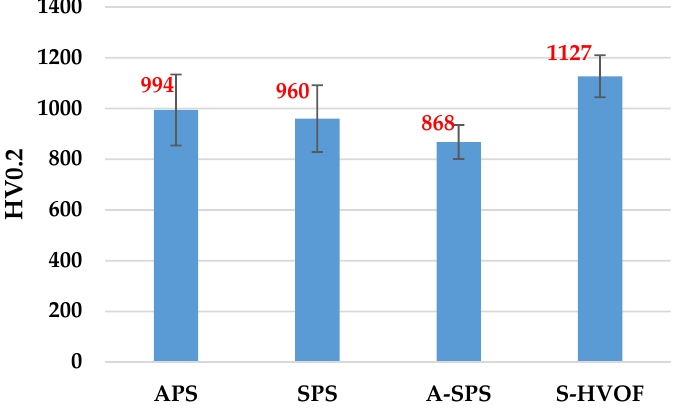
Figure 5. Vickers’ microhardness of deposited Al 2 O 3 coatings.